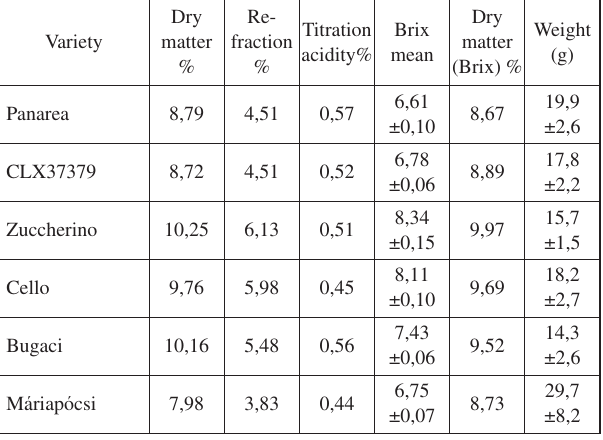
Table 4. Refraction and weight results of varieties